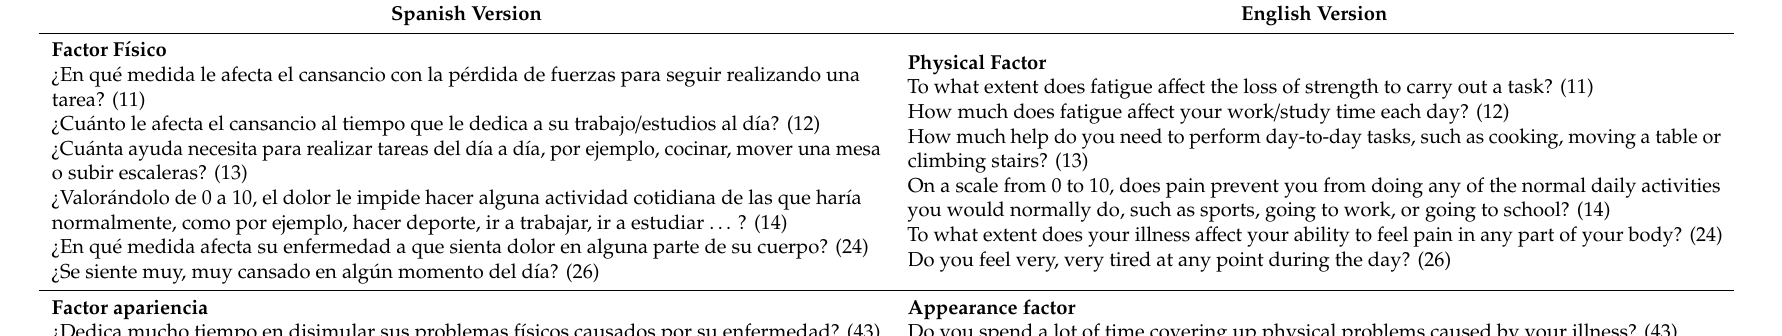
Table A1. LEQoL instrument Spanish and English